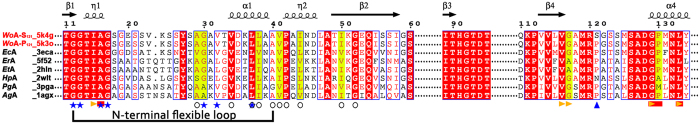
Sequence alignment of select bacterial L-asparaginases.Despite the key function of the flexible N-terminal loop (boundaries indicated by square bracket), amino acid sequence conservation is limited to the first segment, to the tyrosine that approaches the ligand (Tyr27 in WoA), and several hydrophobic residues. In this alignment, the strictly and mostly conserved residues are highlighted in red and yellow, respectively. Open circles indicate conserved hydrophobic residues stabilizing the N-terminal loop in one or both conformations. Blue stars and orange arrows indicate conserved hydrophobic residues stabilizing the loop in its closed/active and open/inactive conformations, respectively. Red boxes indicate conserved hydrophobic backbone residues stabilizing the internal-hinge, Ile15 in WoA. Blue arrow shows the amino acid at position 121st in WoA. The secondary structure shown above the primary sequence is based on the WoA-P121 + Asp structure (PDB ID 5K3O). Numbering is based on WoA sequence. The UniProt entries of corresponding crystal structures used for this alignment are: Wolinella succinogenes L-asparaginase, WoA-S121 + Asp_5K4G, P50286; Escherichia coli L-asparaginase, EcA_3ECA, P00805; Erwinia chrysanthemi L-asparaginase, ErA_5F52, P06608; Erwinia carotovora L-asparaginase, EtA_2HLN, Q6Q4F4; Helicobacter pylori L-asparaginase, HpA_2WLT, O25424; Pseudomonas sp. L-asparaginase, PgA_3PGA, P10182 and Acinetobacter glutaminasificans L-asparaginase, AgA_1AGX, P10172.